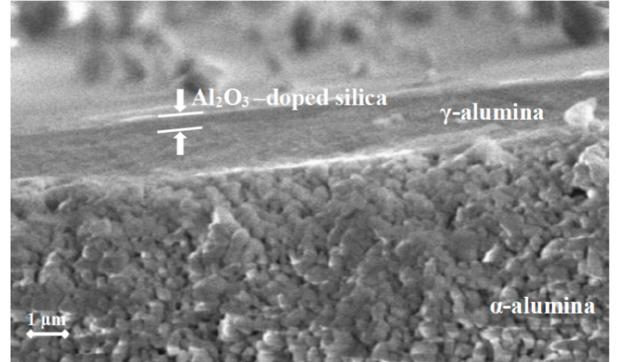
Figure 2. Cross-sectional SEM micrograph of the membrane used in this study. The Al 2 O 3 -doped silica NF layer is coated over a mesoporous γ -alumina interlayer and a macroporous α -alumina support.